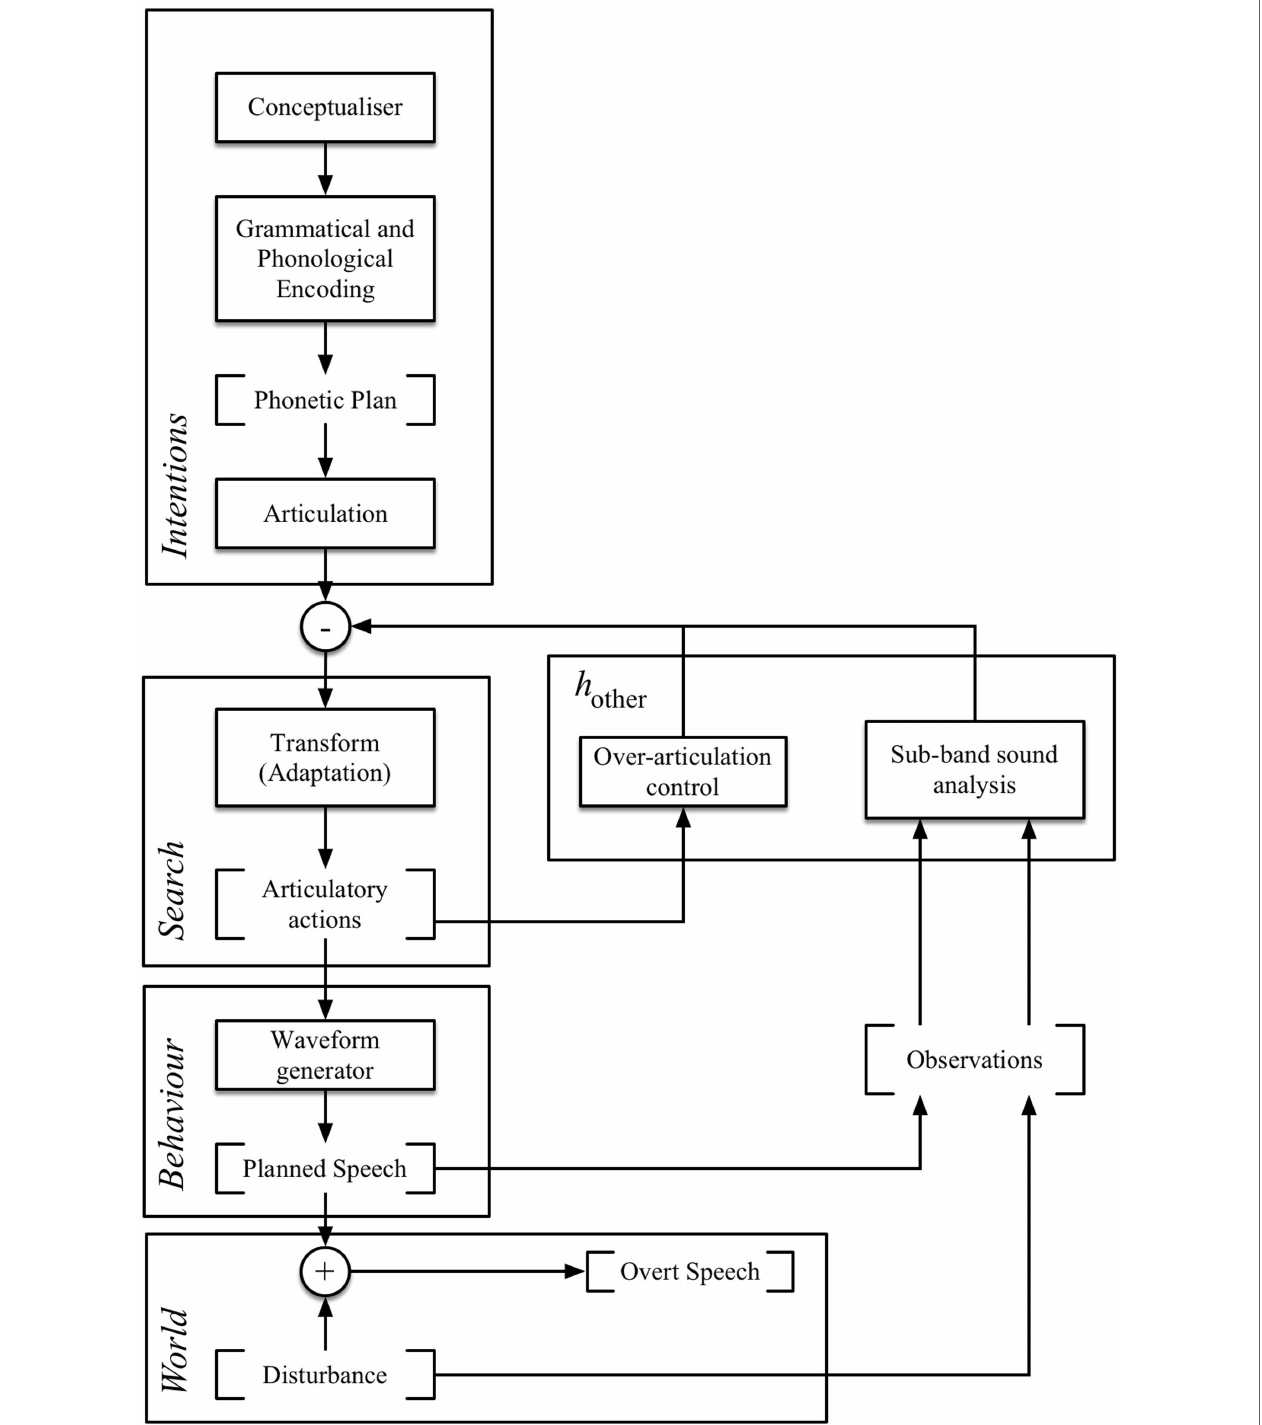
FIGURE 10 | Illustration of the C2H model of speech production (speech synthesiser on the left, auditory feedback loop on the right, adaptive control in the center).